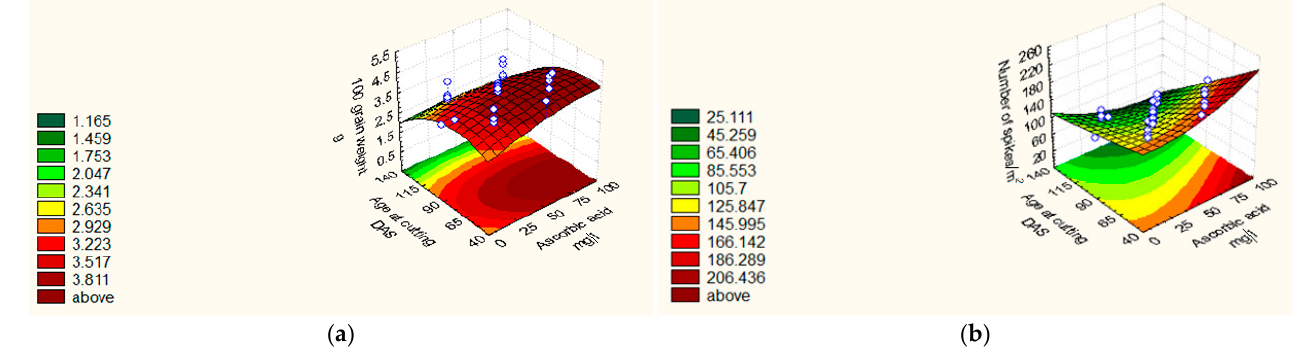
( d ) ( e ) Figure 7. Response surface for 100-grain weight ( a ), number of spikes m − 2 ( b , c ) and plant height ( d , e ) in the two respective seasons as affected by AA and AC at the central levels of AA and HA. ( a ) ( b ) Figure 8. Response surface for grain yield as affected by PF and HA at the central levels of AA, and AC in ( a ) 2018/19 and ( b ) 2019/20.